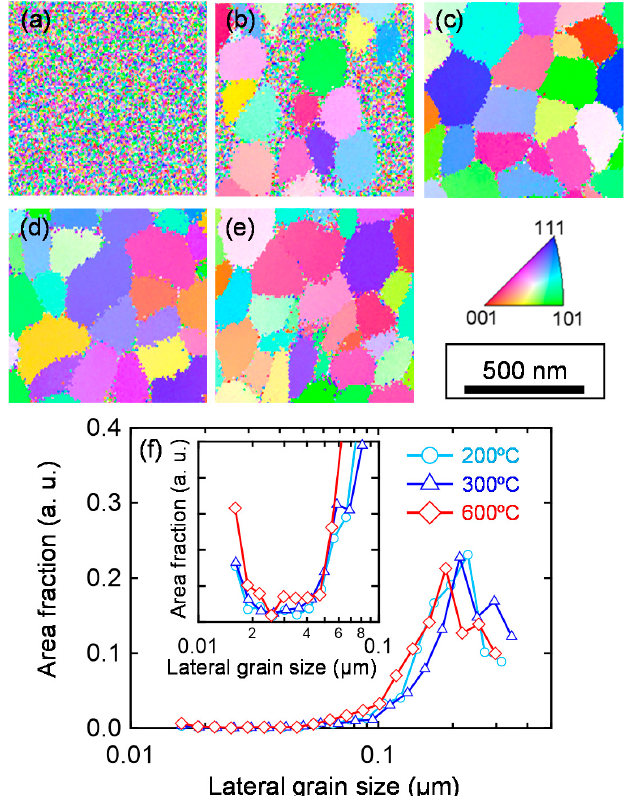
Figure 4. EBSD images of the ( a ) as-deposited, ( b ) 150 °C, ( c ) 200 °C, ( d ) 300 °C, and ( e ) 600 °C annealed In 2 O 3 :H films. ( f ) Area fraction of each grain size obtained from the In 2 O 3 :H films with various T ann values. The inset shows a magnified view of the small area fraction at a small grain size. To understand the mechanism of structural deterioration at the grain boundaries of In 2 O 3 :H films at T ann ≥ 400 °C, we performed TDS measurements. Figure 5 shows the TDS spectra of H 2 , H 2 O, O 2 , and In for the In 2 O 3 and In 2 O 3 :H films. We first note that H 2 , O 2 , and In desorption were negligible for both types of films, while the H 2 O desorption was high for the In 2 O 3 :H film in particular. Large amounts of H 2 O were desorbed at a stage temperature of 400–800 °C for the In 2 O 3 :H film (Figure 5b). The amount of hydrogen in the film was quantitatively evaluated using SIMS, and it was found that 2.6 × 10 21 cm − 3 of hydrogen remained in the film after SPC at 300 °C, which was one order of magnitude higher than that of the In 2 O 3 film. The H 2 O desorption temperature (400 °C) for the In 2 O 3 :H film corresponded well to a T ann of 400 °C, at which the μ H of the films started to degrade. During annealing at a T ann of 400 °C and higher, H or –OH inside grains may migrate to grain boundaries and react with a neighboring H at the boundary, resulting in the gener- ation of H 2 O molecules. As a consequence, defects are formed at grain boundaries. In other words, the presence of H and/or –OH bonds in the In 2 O 3 :H film after SPC plays an im- portant role in the passivation of defects, especially for grain boundaries. In general, the SS value of a TFT is strongly affected by defects near the semiconductor Fermi level [2,12]. We recently reported from hard X-ray photoelectron spectroscopy analysis that intention- ally introduced hydrogen is effective in reducing defects near the Fermi level in amor- phous IGZO [40–44]. The SS values of the In 2 O 3 :H TFTs, shown in Figure 2d, increased at a T ann of 400 °C and higher, indicating defect creation. Thus, we believe that the H and/or –OH bonds remained in the films after SPC passivated the defects near the Fermi level, leading to the high μ FE and steep SS values of the In 2 O 3 :H TFT annealed at 300 °C. Thus,